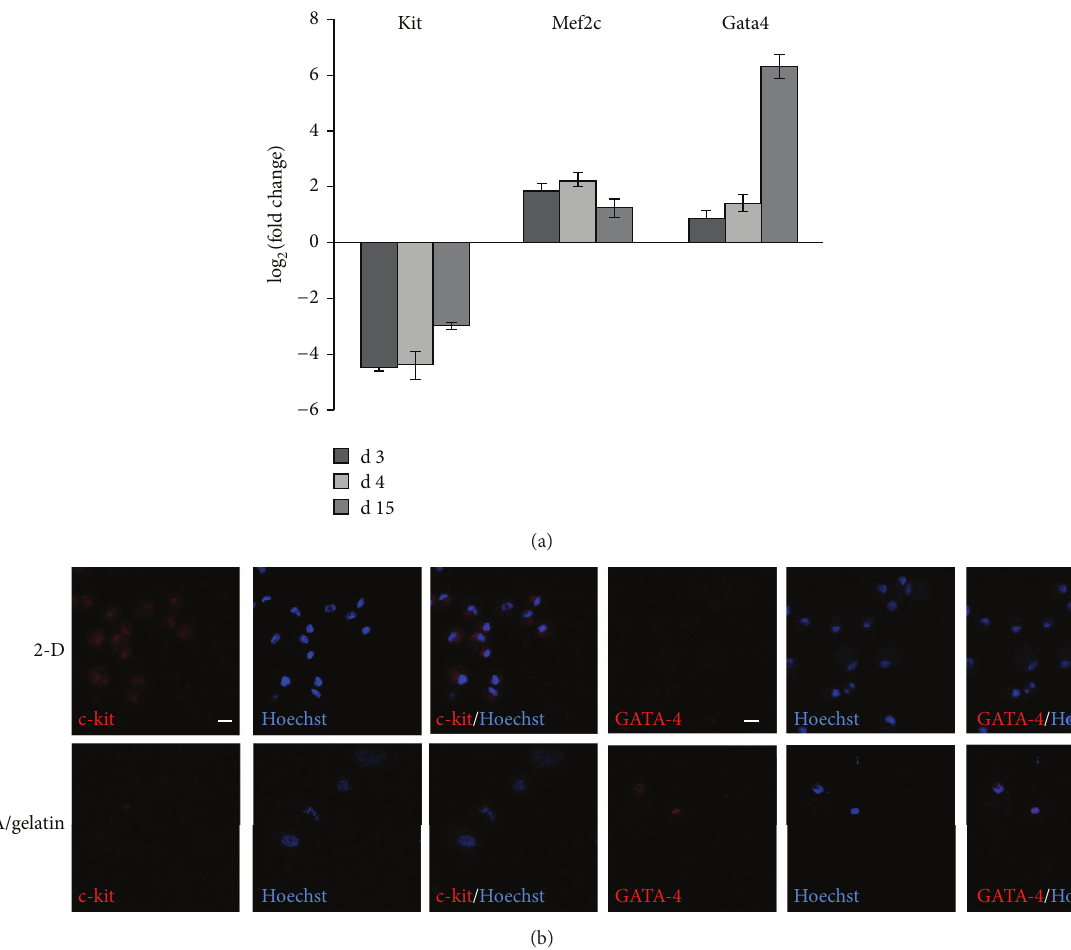
Figure 8: Analysis of stemness and cardiac differentiation markers. (a) qPCR results for hMSCs cultured for 3, 4, and 15 days on monolayer microstructured PLGA/gelatin scaffolds. The expression of the same genes in 2D control cultures was used for normalization. (b) Representative confocal immunofluorescence images of c-kit and GATA-4 proteins (red) and nuclei (blue) in hMSCs after either 2D control culture (top panel) or 15-day culture (bottom panel) on microstructured bilayer PLGA/gelatin scaffolds. Magnification 63x, scale bar 20 𝜇